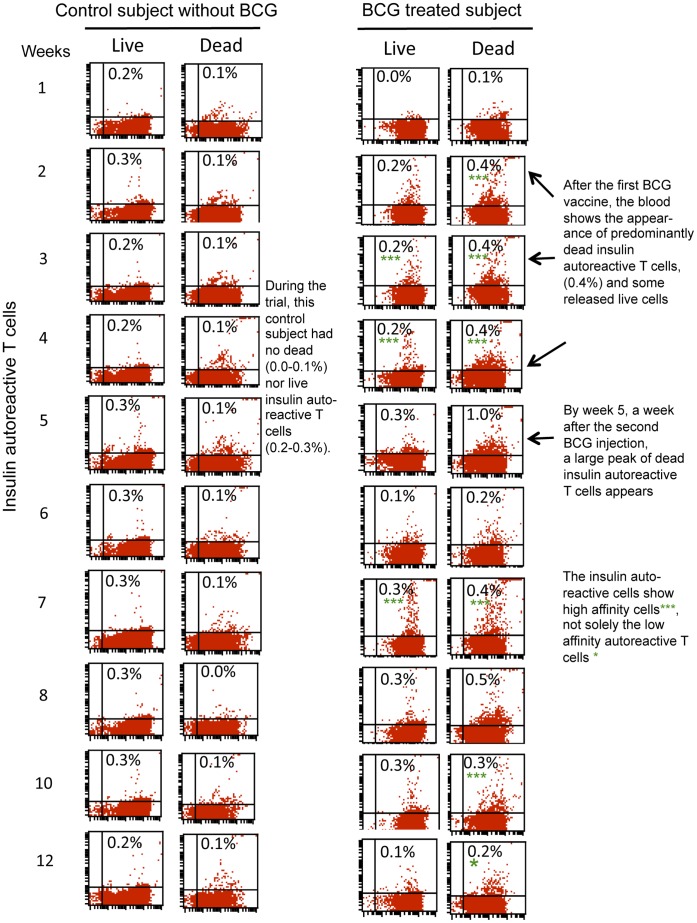
Two-color flow pictures of the serial weekly blood monitoring of dead and live insulin autoreactive T cells in a control subject (left) and BCG-treated diabetic subject (right).After the first BCG treatment, predominantly dead insulin-autoreactive T cells appear in the circulation of the diabetic compared to the simultaneously studied paired healthy control. For all recruited BCG-treated diabetic subjects, the start of the trial shows fresh blood samples with no insulin-autoreactive T-cells in these longterm diabetics, followed by dead insulin-autoreactive T-cells that persist through week 4, recurrent dead insulin-autoreactive cells released again after the second injection of BCG followed by the gradual disappearance of the dead insulin-autoreactive T-cells by week 12 of monitoring. It should be noted that the newly released insulin-autoreactive cells after BCG are unique in representing both low affinity (*) autoreactive T-cells that can be observed in the routine monitoring of positive patients and high affinity(***) autoreactive T-cells that are never observed in routine monitoring of diabetic patients. In contrast to the serial monitoring of a BCG treated subject, the serial studied fresh blood samples of the control subject reveal throughout the study the lack of either live or dead insulin-autoreactive T-cells.